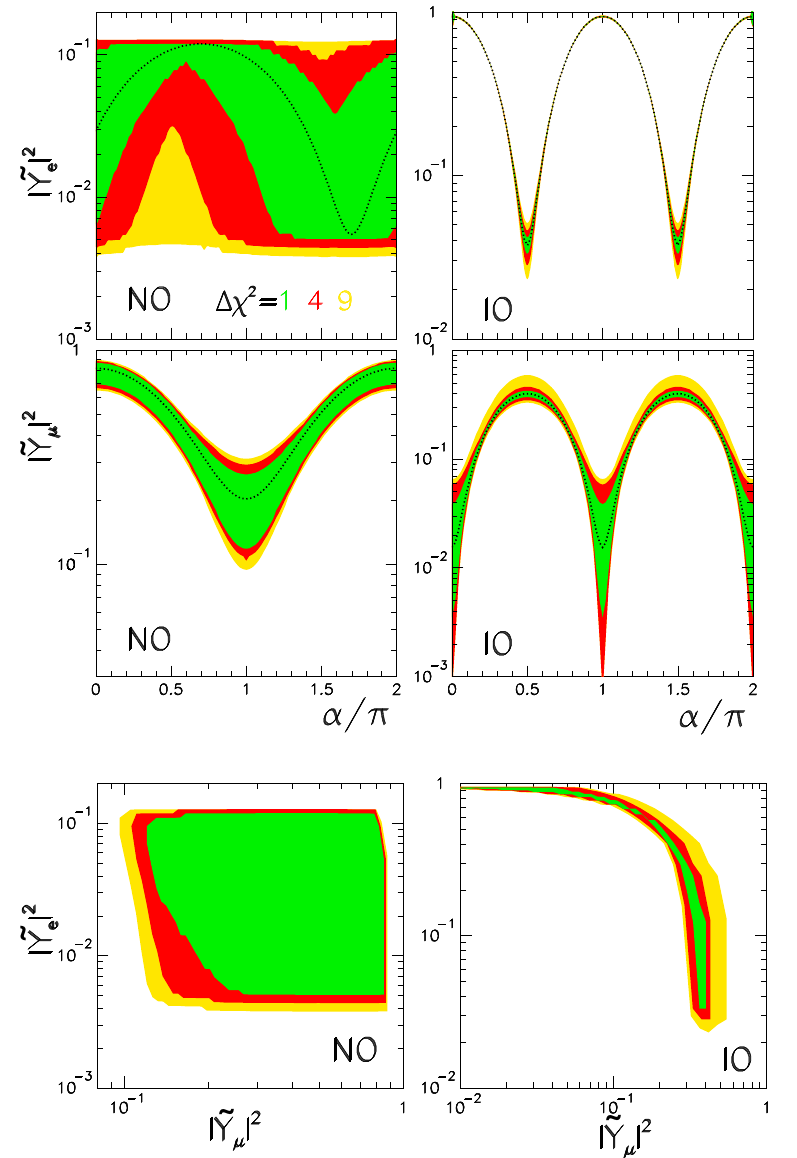
Figure 1 . Allowed ranges of the Yukawa couplings j ~ Y e j 2 (cid:17) j Y e j 2 =y 2 and j ~ Y (cid:22) j 2 (cid:17) j Y (cid:22) j 2 =y 2 obtained from the global analysis of neutrino data in ref. [35]. The upper four panel shows the values of the couplings as a function of the unknown Majorana phase (cid:11) . The correlation between the two couplings is shown in the two lower panels. The left (right) panels correspond to normal (inverted) ordering. The dotted line corresponds to the best (cid:12)t values. The ranges in the (cid:12)lled green, red and yellow areas are shown at 1 (cid:27) , 2 (cid:27) , and 3 (cid:27) with 1 dof ((cid:1) (cid:31) 2 = 1 ; 4 ; 9 respectively).